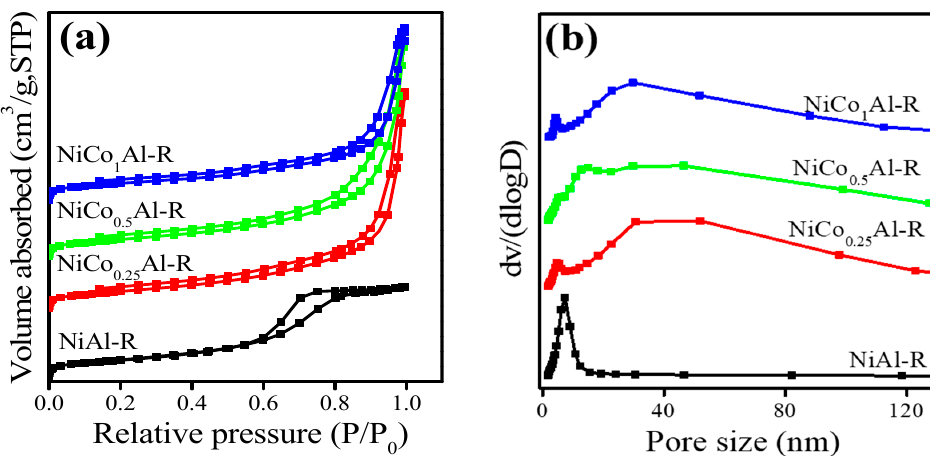
Figure 2. N 2 adsorption–desorption isotherms of NiCo x Al-LDHs ( a ); pore size distribution curves of NiCo x Al-R catalysts ( b ).